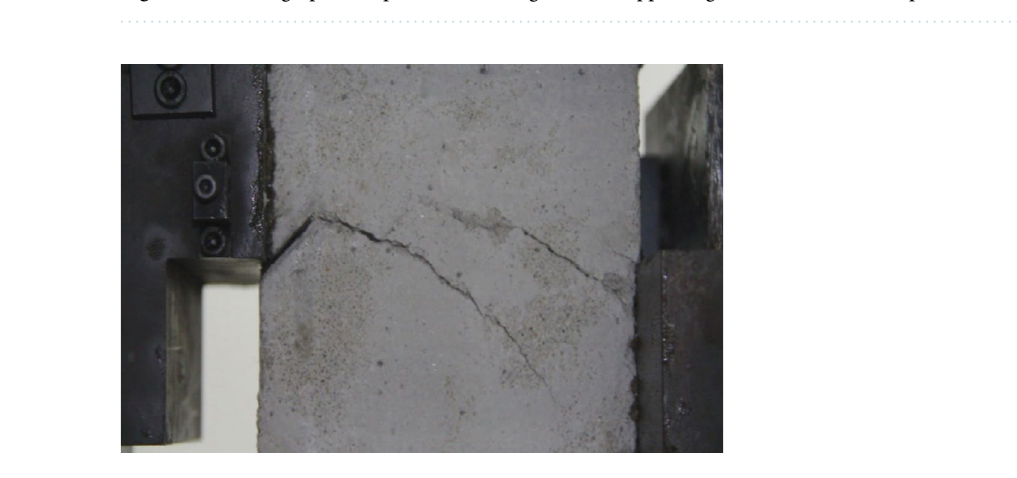
Figure 44. Photograph of a specimen showing fractures propagating and